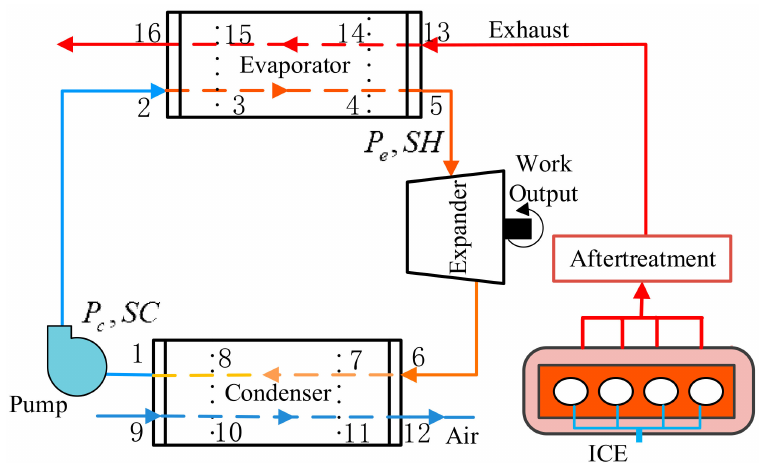
Figure 1. The schematic of the onboard ORC system in this